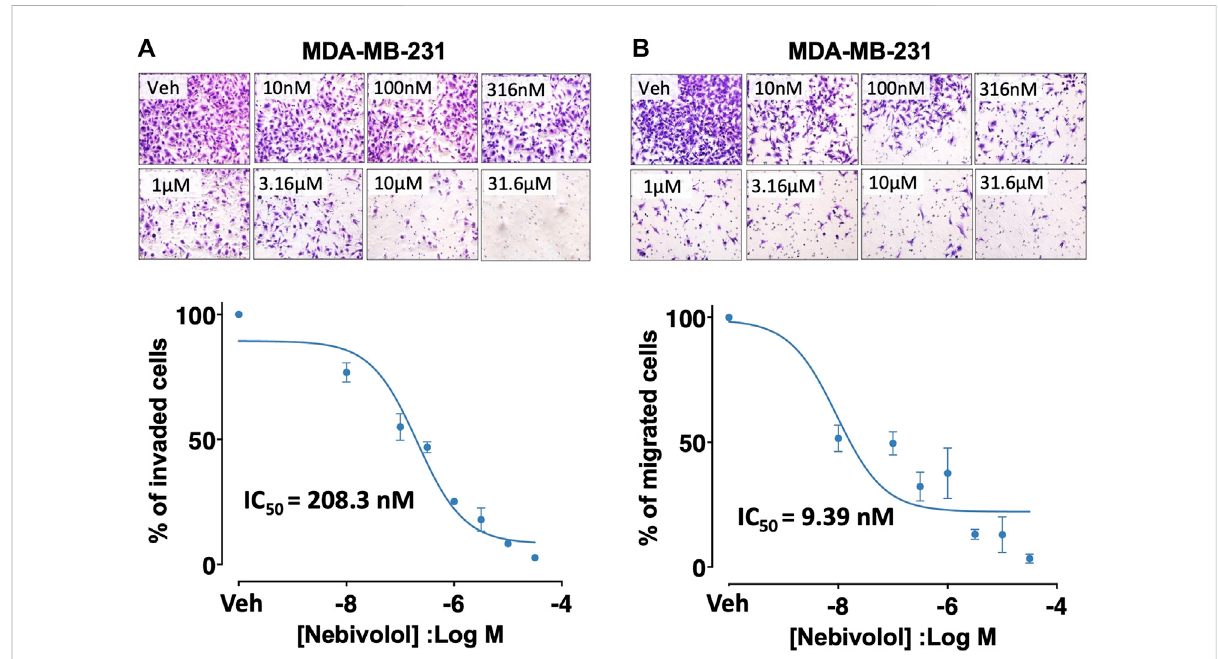
FIGURE 3 Effects of nebivolol on invasion and migration potentials in MDA-MB-231 cells. Nebivolol (1 nM – 31.6 µM) effects on (A) invasion and (B) migration potentials in MDA-MB-231